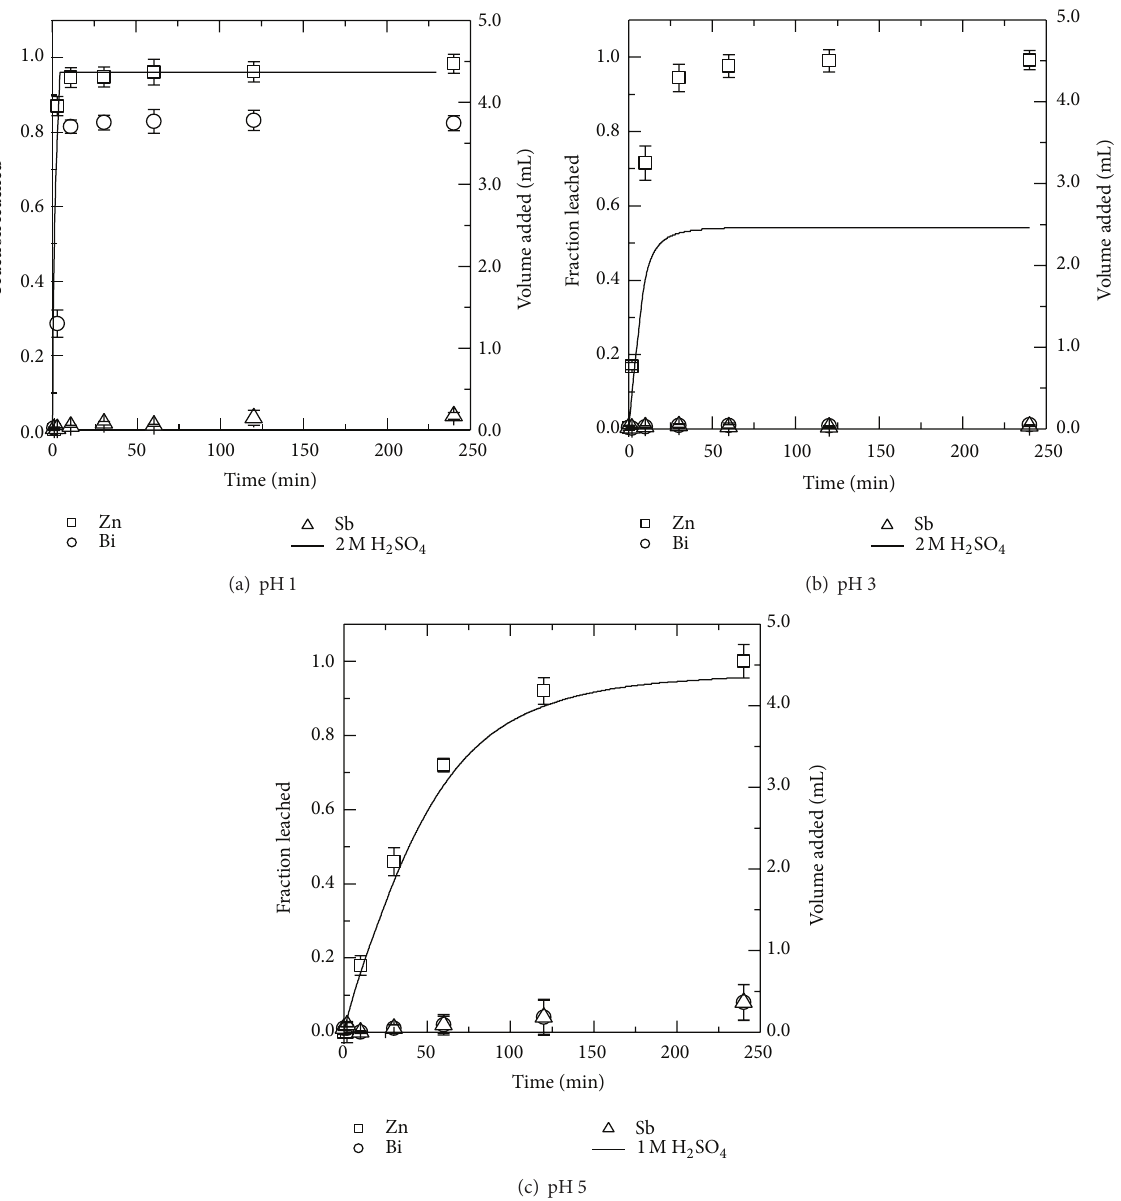
Figure 6: The leached fraction as given by the left ordinate for zinc ( ◻ ), bismuth ( I ), and antimony ( 󳵻 ) from MOV in (a) pH 1, (b) pH 3, and (c) pH 5 solutions. The volume and concentration of sulfuric acid (H 2 SO 4 ) added is shown as a solid black line corresponding to the right